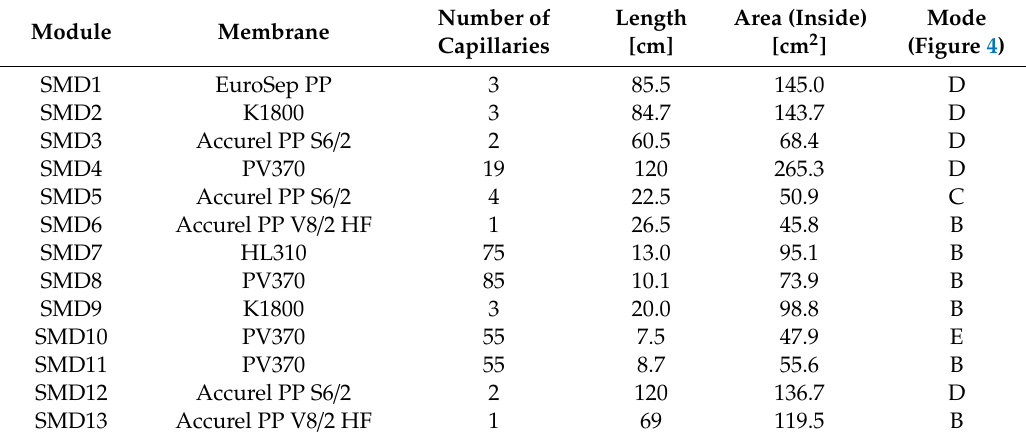
Table 2. Parameters of submerged MD modules.